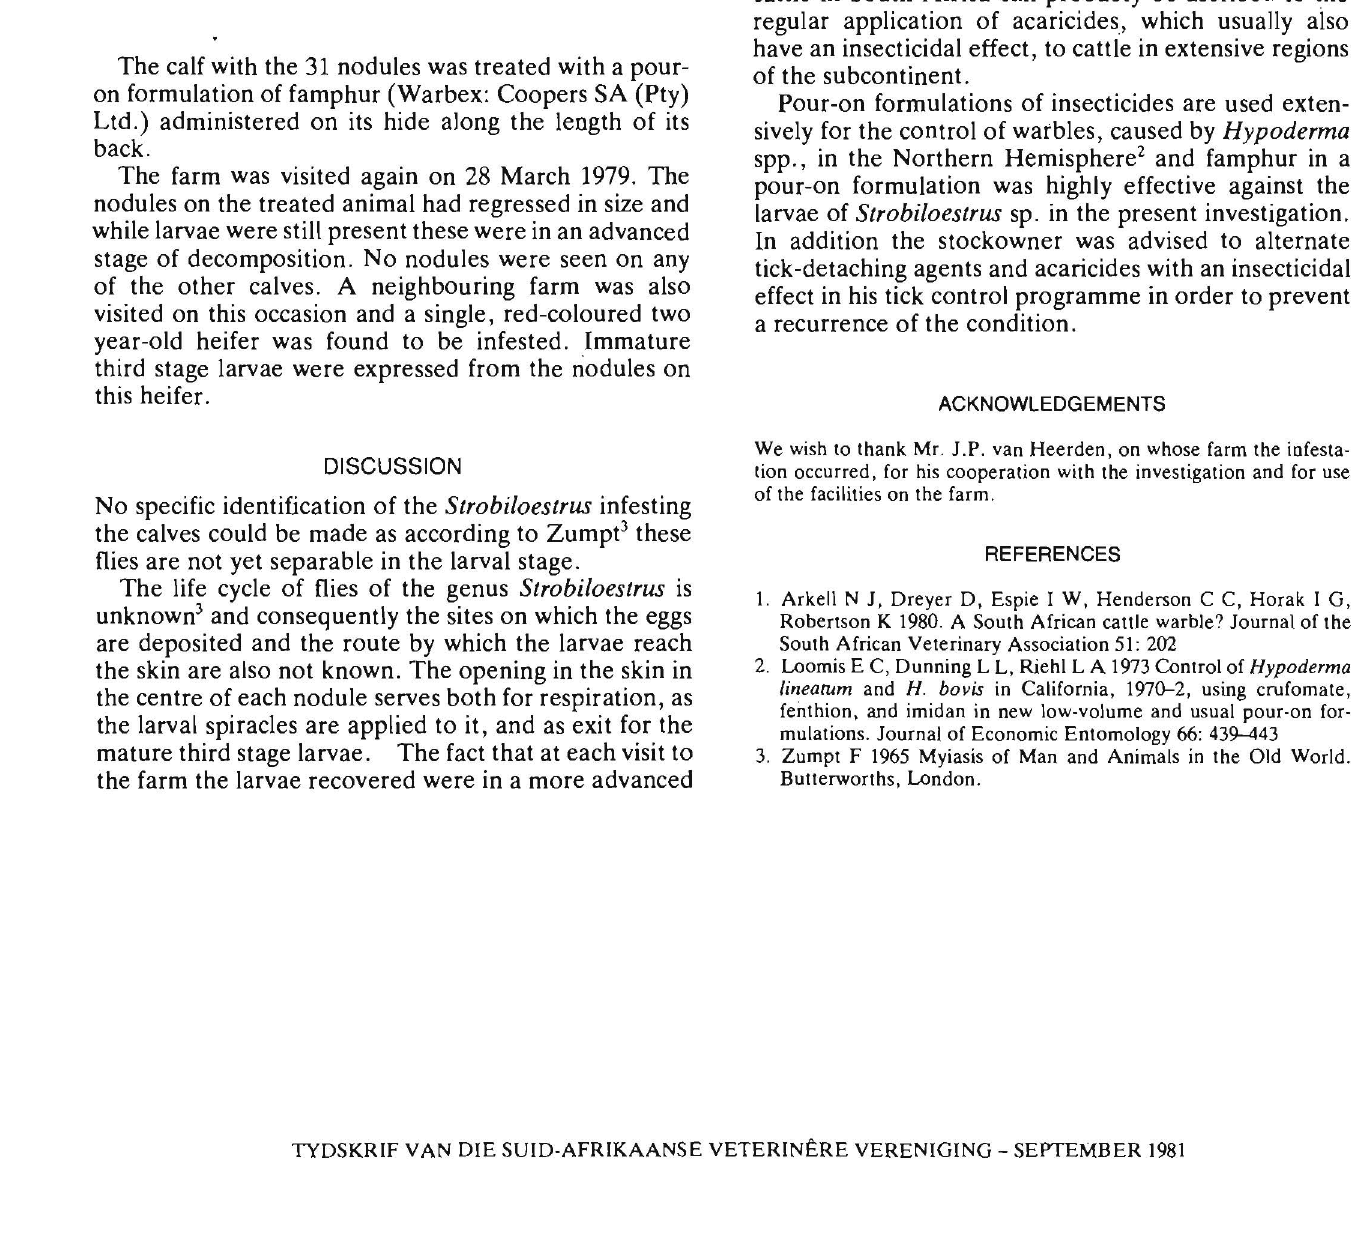
Fig. 3 Second stage larva of Strobiloestrus sp. expressed from a nodule in the skin of a calf.